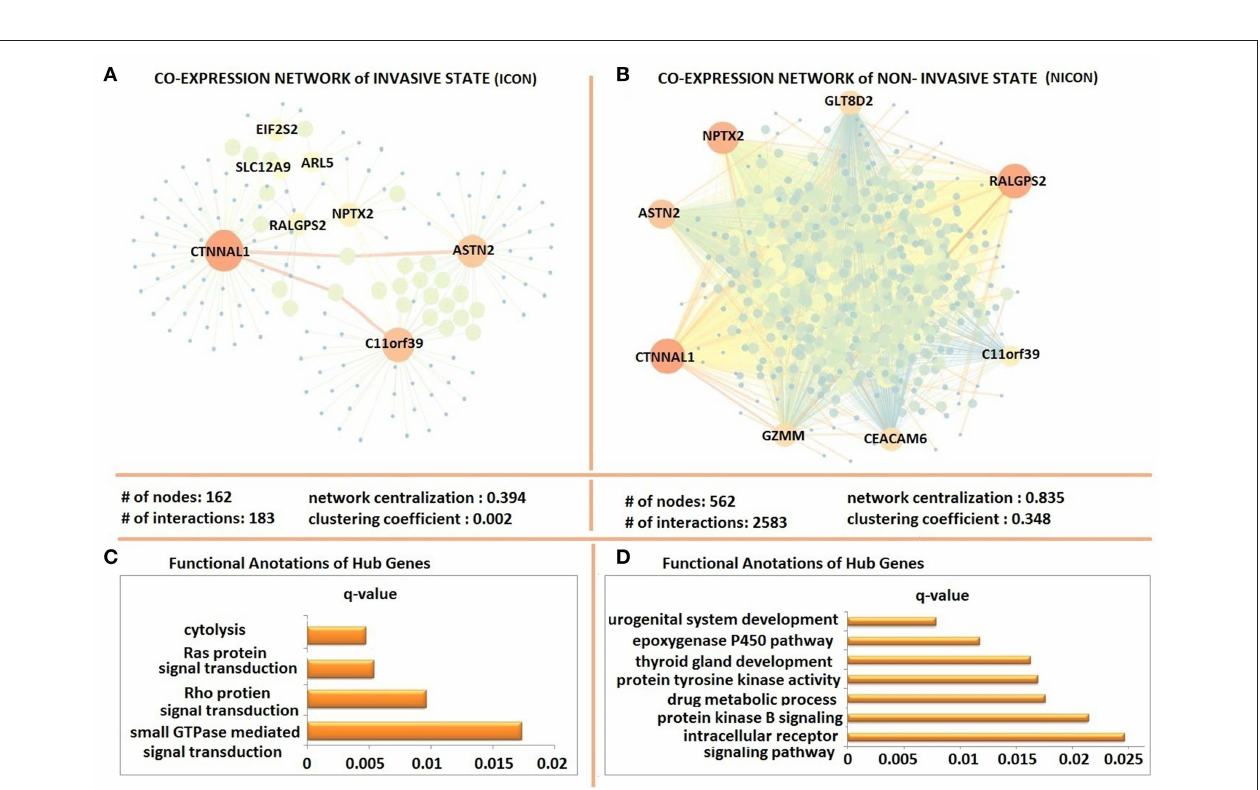
FIGURE 3 | Differentially co-expressed gene networks of invasive and non-invasive states. (A) The co-expression network in invasive phenotype (ICON) with 183 links among 162 and topological features of ICON (B) the non-invasive co-expression network (NICON), which includes 2,385 links among 562 genes and topological features of the network (C) Functional annotations of ICON hub genes (D) Functional annotations of NICON hub genes.